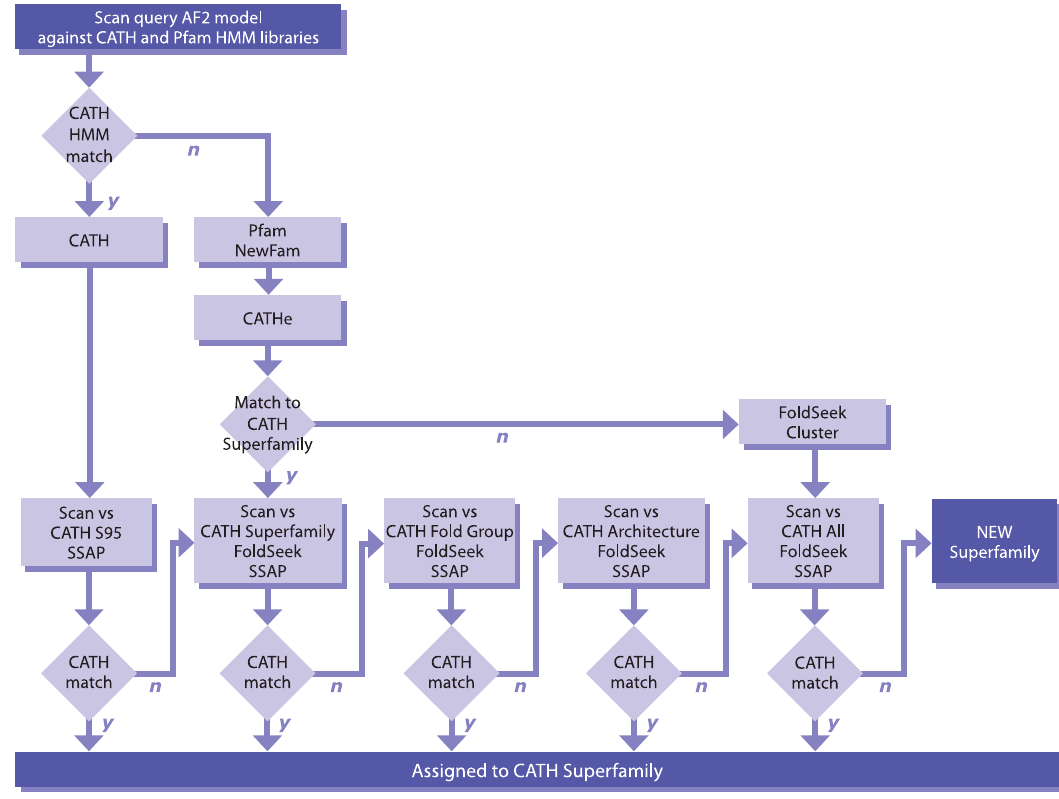
Fig. 1 Overview of the CATH-Assign protocol used to process the predicted AF2 domains. CATH-HMM (labelled as CATH) are structurally compared against the Superfamily non-redundant representative that they match. Pfam and NewFam domains are classi fi ed into CATH Superfamilies using the CATHe predictor where possible. A cascade method is used to validate, starting with structure scans against non-redundant domains in the CATHe predicted Superfamily, then the predicted Topology, Architecture, and fi nally domains from all superfamilies if necessary.